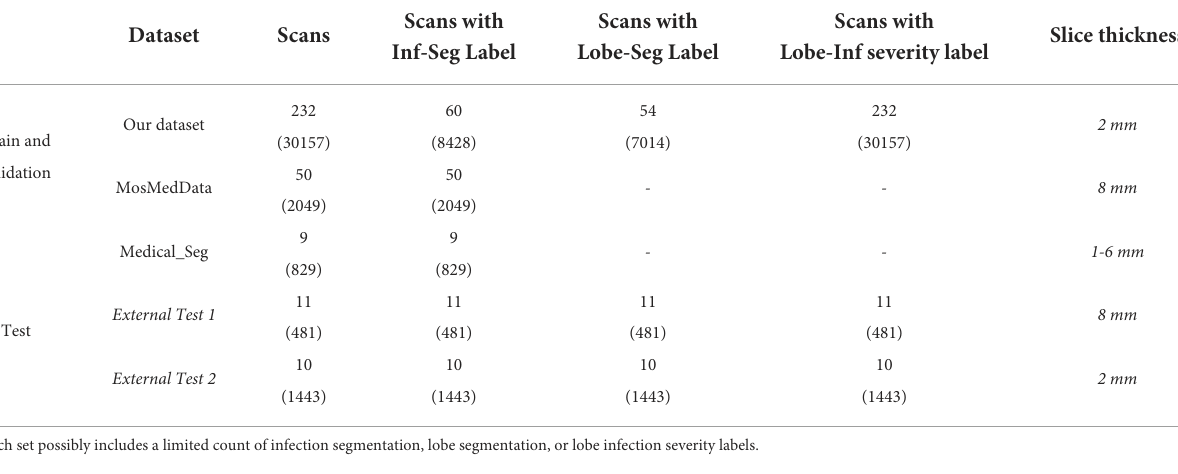
TABLE 1 Involved datasets with their respective label count.